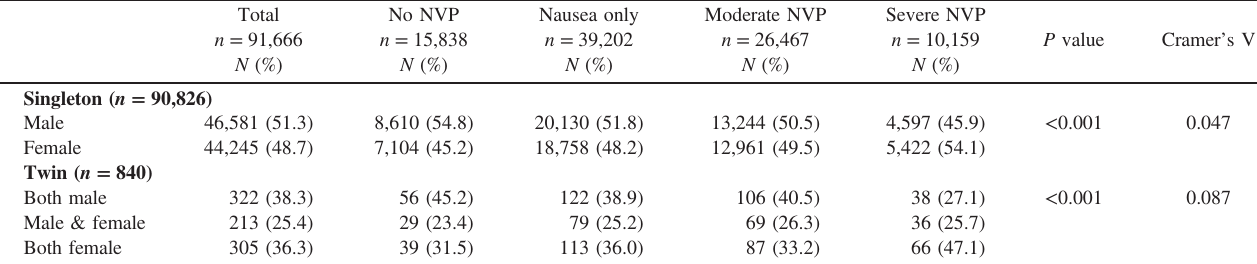
Table 2. Fetal sex according to NVP status